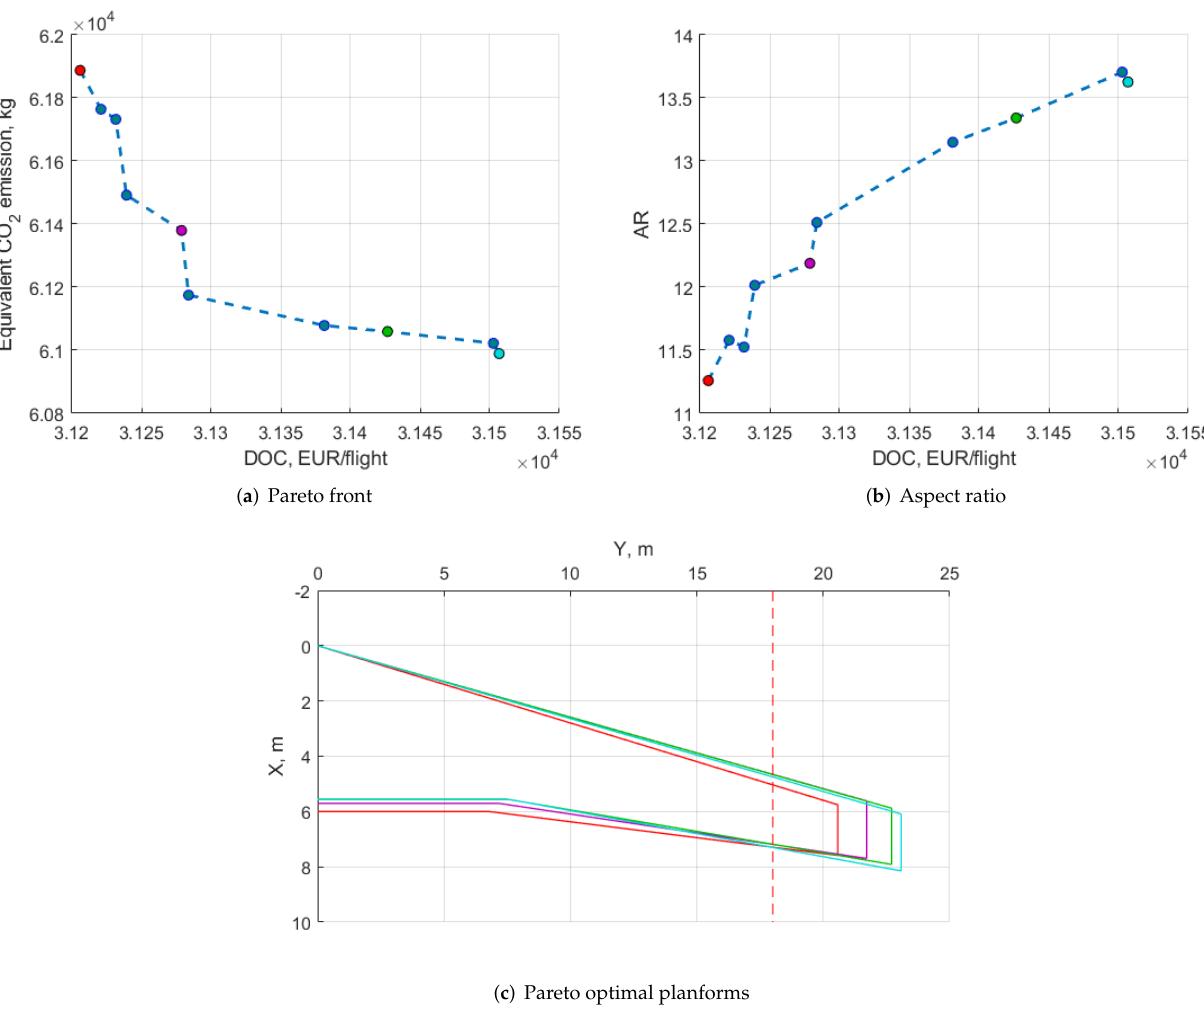
Figure A5. Optimization results for the backward-swept NLF